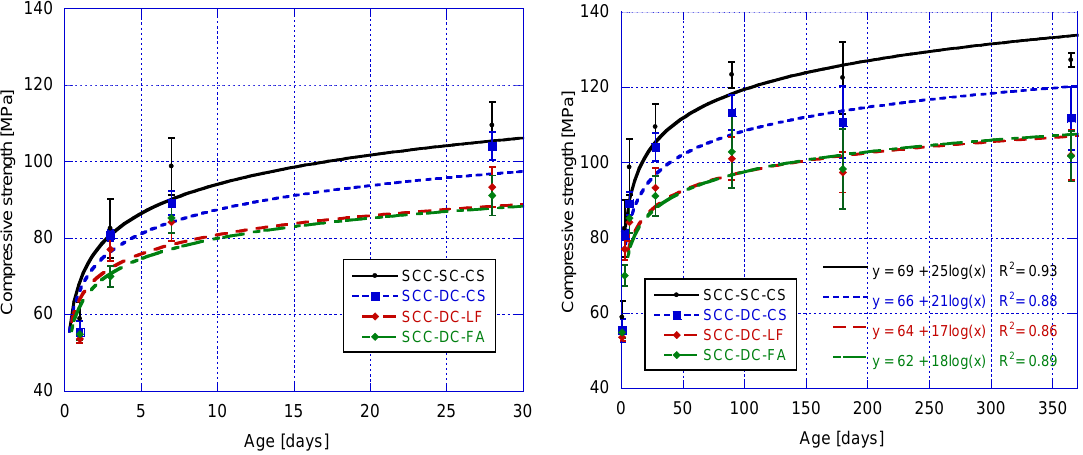
Figure 5. Evolution of the compressive strength for the different mixes: the first at 28 days (left) and the second at 360 days (right).